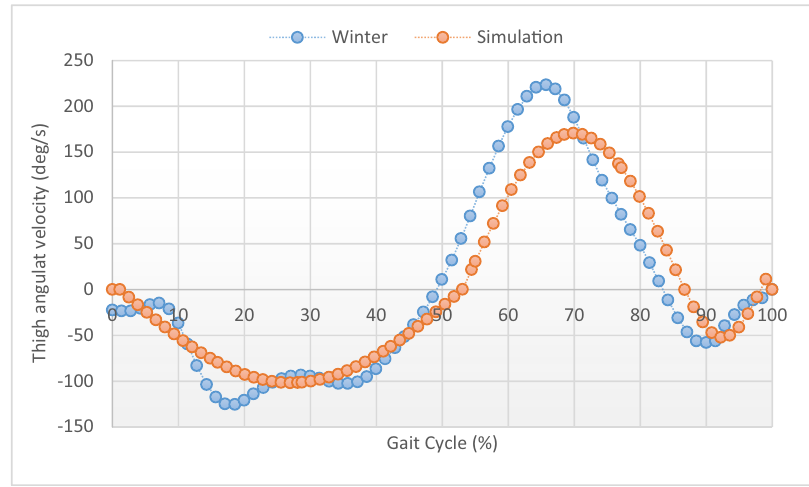
Figure 18: Thigh joint angular velocity versus gait